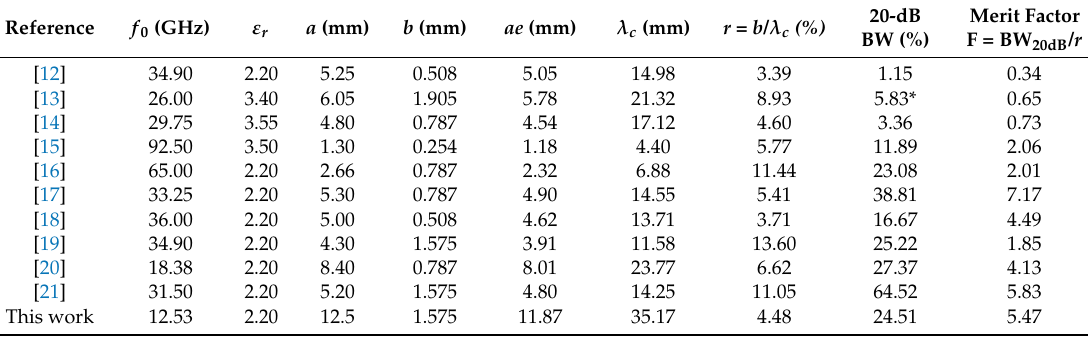
Table 6. Comparison between RWG-to-SIW transitions in referenced